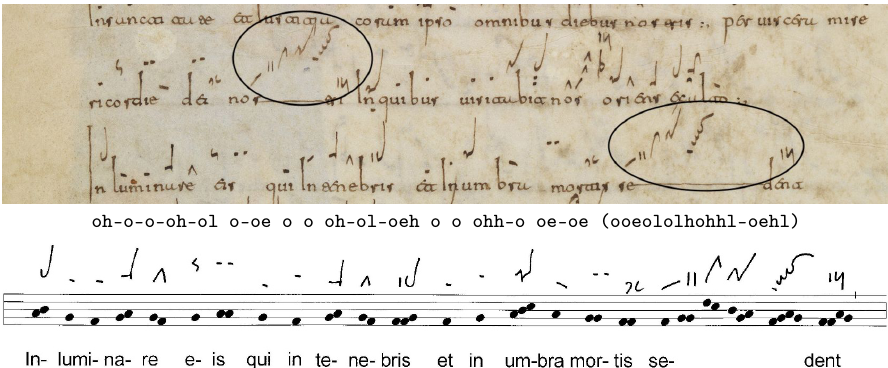
Figure 1. Two lines of the Canticum Zachariae for the feast of St. John the Baptist from the León antiphoner (E–L 8, 215r4–5). Encircled is an intra-opus repeating pattern. On the second line of the León image the beginning of the last verse; Inluminare eis . Below the León image is a representation in contour letters of this second line, and below that the corresponding passage of our generated performance score with